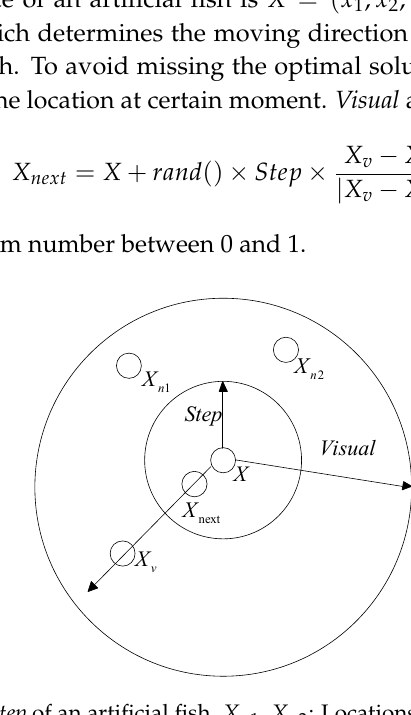
n 1 , X n 2 : Locations of two fish within